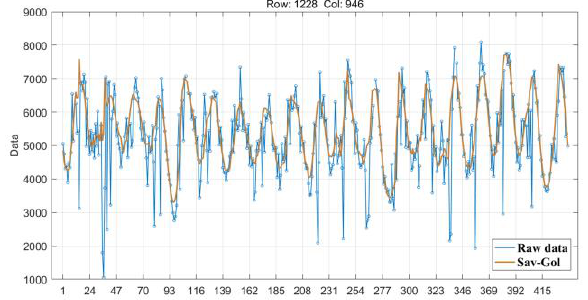
Figure 3. MODIS NDVI pixels of raw data (blue line) and filtered information (brown line) of filtered NDVI image time series data from 2001 to 2019 using the Savitzky-Golay (S-G) method.